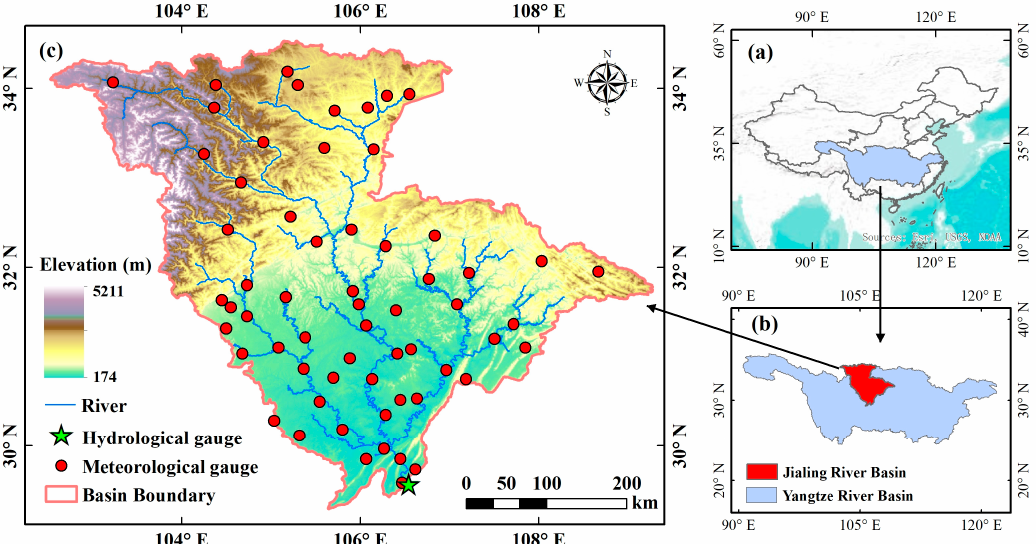
Figure 1. The location and topography of the study area. ( a ) is the JLJ basin, ( b ) is the location of the